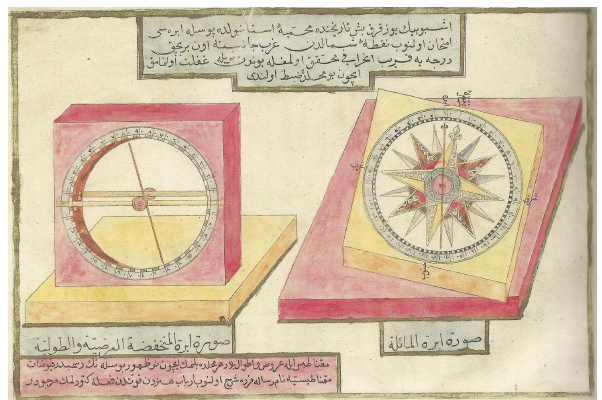
Figure 2b. Inclining and dipping needle illustrations from the book